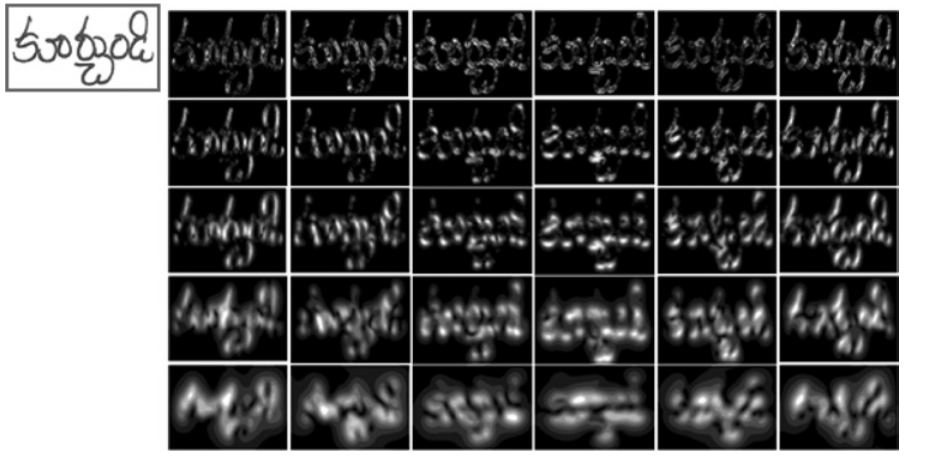
Figure 4: Output Images of Gabor Wavelet Transform on a Sample Handwritten Telugu Word Image (Left) for Five Different Scales and Six Different